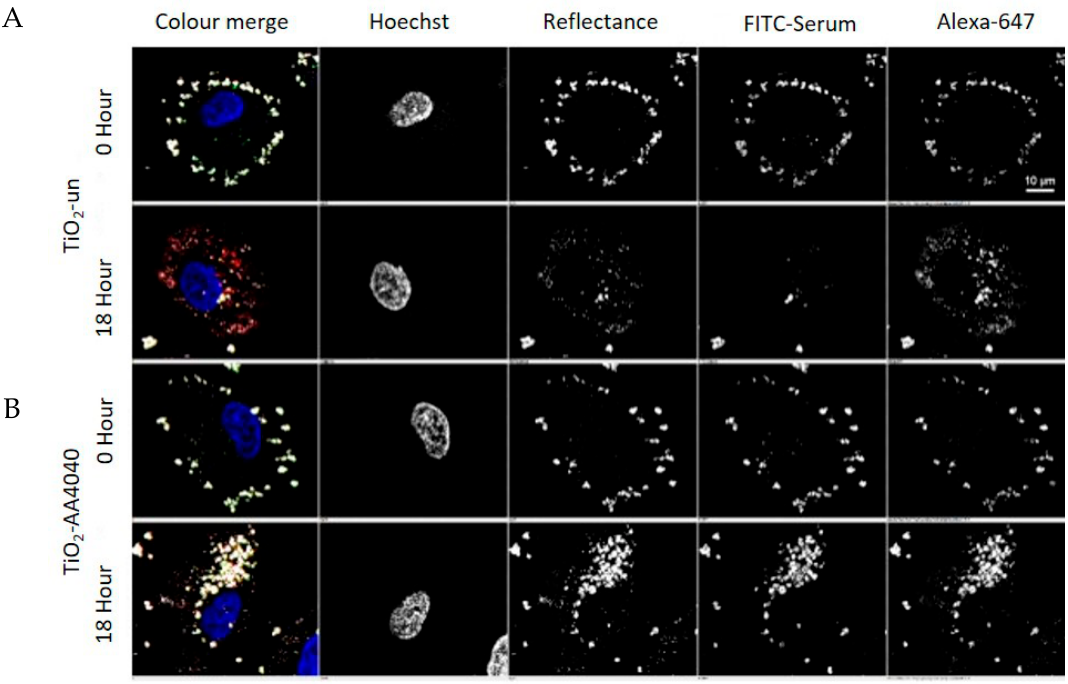
Figure 6. A549 cells incubated with TiO 2 NMs in FITC-labeled serum, followed by a post-incubation period in Alexa-647-labeled serum for 15 min (0 h) and 18 h prior to fixation and confocal imaging. ( A ) Uncoated TiO 2 NMs (TiO 2 -un) demonstrate a loss of the FITC signal by 18 h, suggesting a loss of the initial corona. Alexa-647-labeled serum remains bound to TiO 2 -un at 18 h, suggesting that the loss of the initial corona signal is likely to be a consequence of protein exchange. ( B ) AA4040 Dispex-coated TiO 2 NMs (TiO 2 -AA4040) demonstrate markedly different spot sizes after internalization at 18 h and retain their initial corona, suggesting that surface modification can play a significant role in the corona exchange kinetics and uptake of TiO 2 NMs. By 18 h, these large agglomerates have been internalized as smaller, more discrete clusters, with FITC-serum molecules more loosely associated within the cluster. dSTORM imaging reveals that some of these clusters were comprised of Alexa-647-labeled serum proteins, suggesting the complete exchange of the initial FITC-serum hard corona with the secondary population of proteins (arrows, Figure 7, row 2). Other clusters exhibit a mix of signal, suggesting that this process was still ongoing at 24 h.